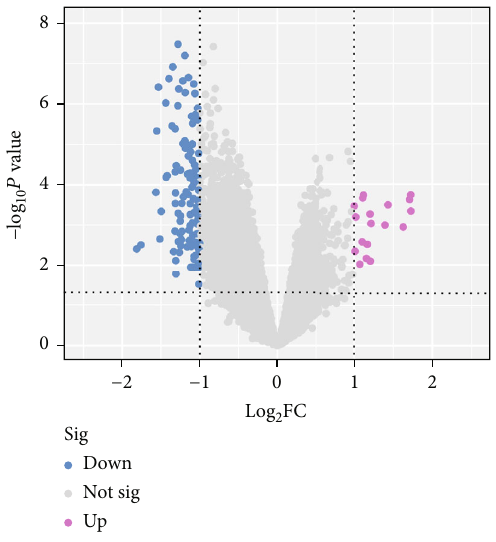
Figure 1: The volcanic map of di ff erentially expressed genes of GSE58331; red dots and green dots represent upregulated and downregulated genes, respectively. P < 0 : 05 , ∣ log 2FC ∣ ≥ 1 .